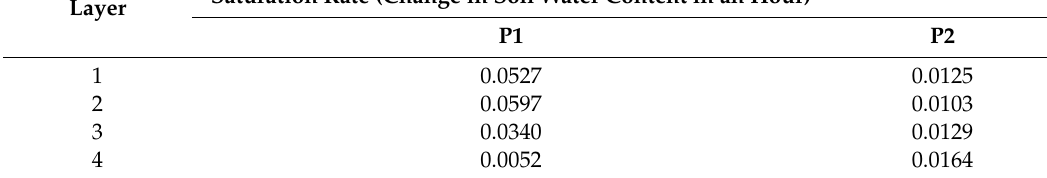
Table 4. Saturation rates depending on soil layers and atmospheric river (AR) periods. The values are areal averages over the Russian river